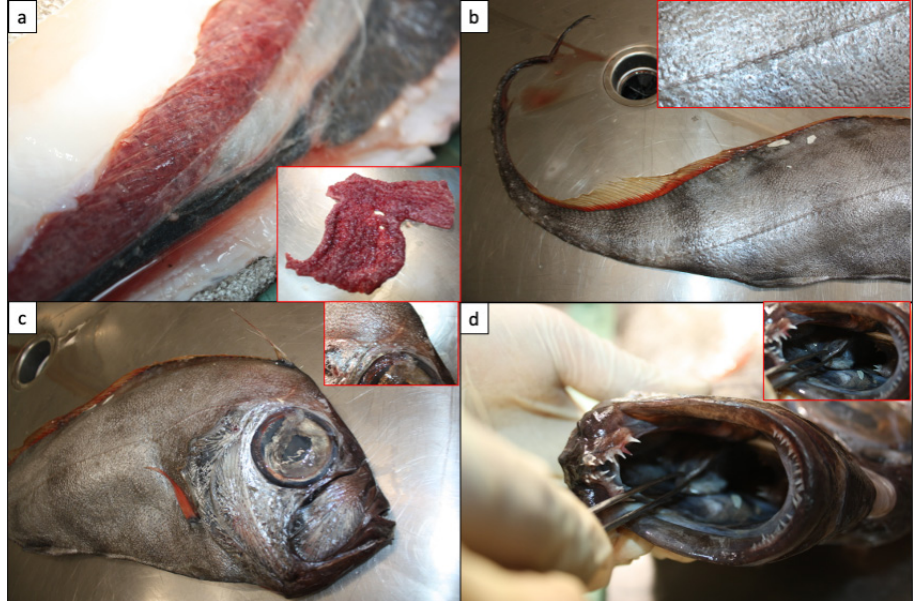
Figure 4. Details of the Z. cristatus specimen analysed in the present study. ( a ) mature female gonads, with details of eggs in the red box; ( b ) posterior part of the Z. cristatus with evident ventral and tail spines, and tubular lateral line scales in the red box; ( c ) anterior part of the specimens, with the large eye, oblique pectoral fin, and the first evidently elongated rays of the dorsal fin, insertion of the lateral line in the red box; ( d ) mouth cavity armed with upper and lower jaws teeth, and some palatine ones in the red box.